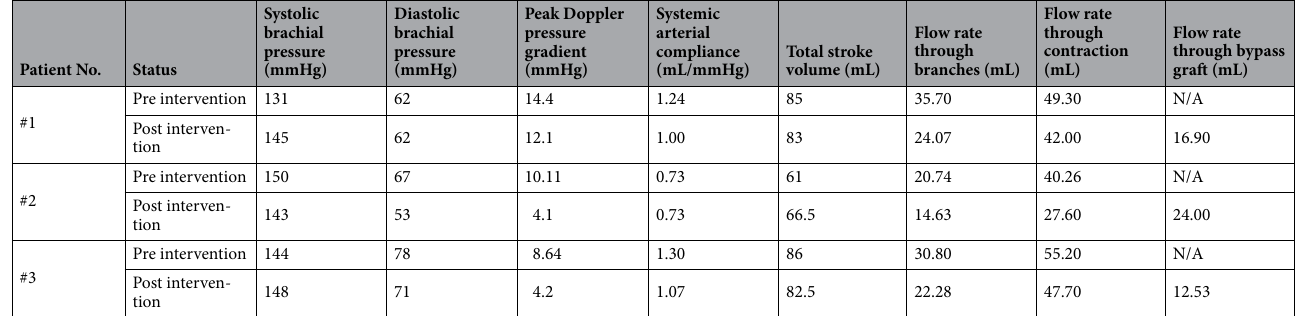
Table 3. Hemodynamics parameters in 3 COA patients who underwent bypass grafting. Note 1: Peak Doppler pressure gradient (Δ P = 4 V max2 ; V max : maximum velocity downstream of COA during systole). Note 2: Systemic arterial compliance (SAC = SV/PP; SV: total stroke volume, PP: pulse pressure (diastolic brachial pressure– systolic brachial